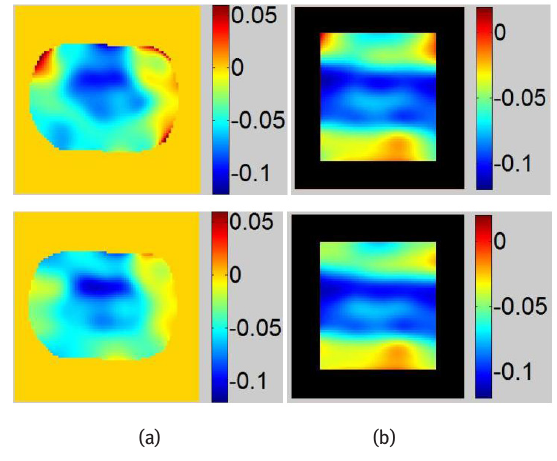
Figure 8: Strain maps obtained with tagged phantom images, Top: Strain maps obtained with original image, Bottom: Strain maps obtained after DC component subtraction, (a) Axial images (b) Sagittal images.